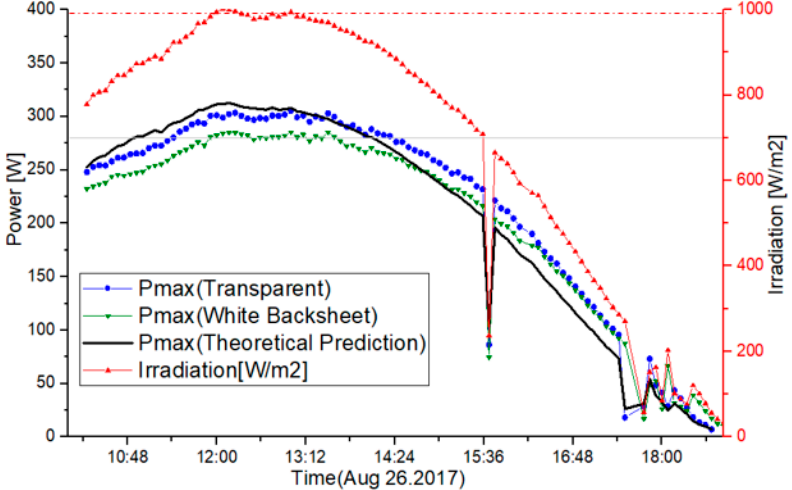
Figure 22. Output comparison between transparent and white back sheet on Exp. 5.